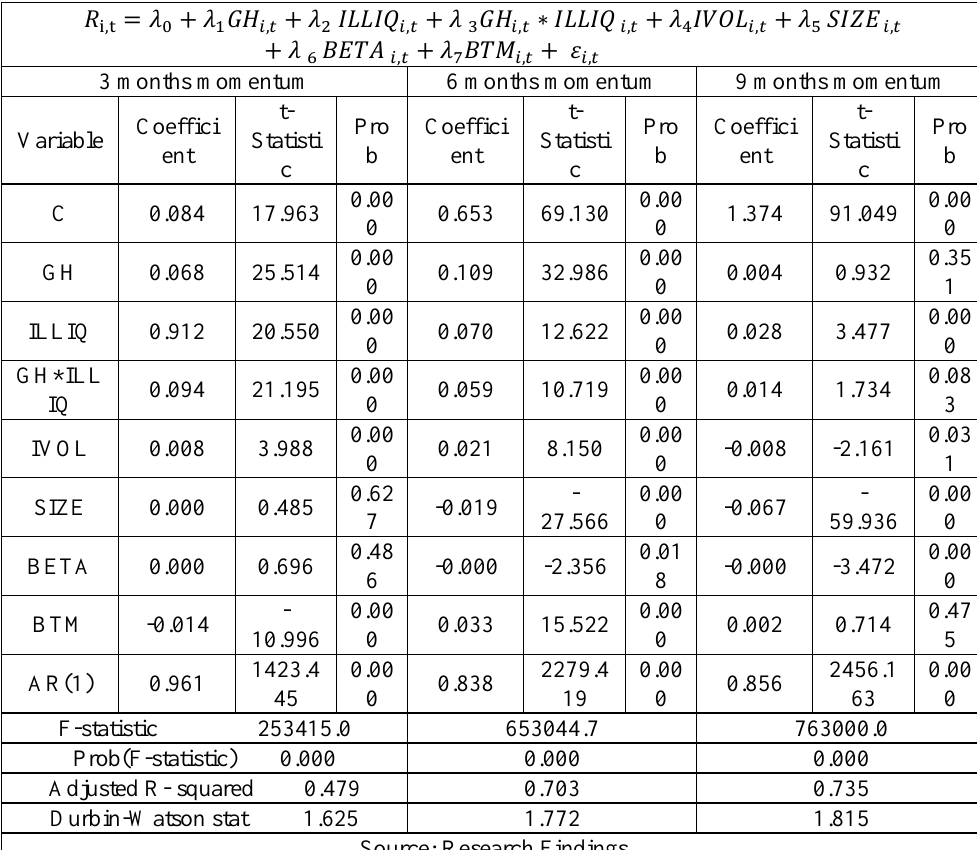
Table 3. Regression results for the effect of anchoring bias in stocks with low liquidity on momentum